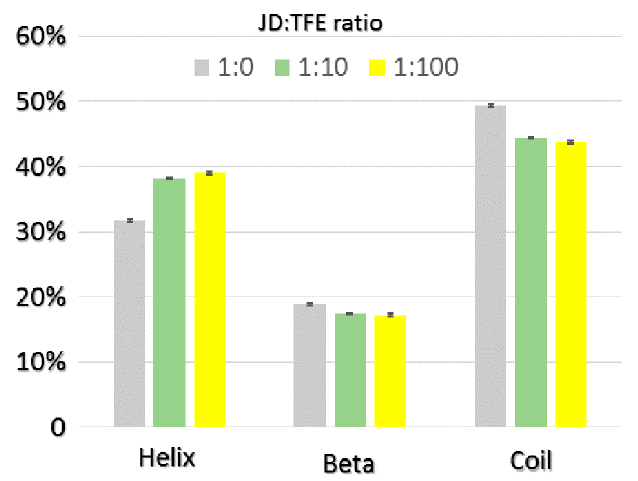
Figure 3. JD secondary structure percentage calculated over the last 20 ns of each MD trajectory